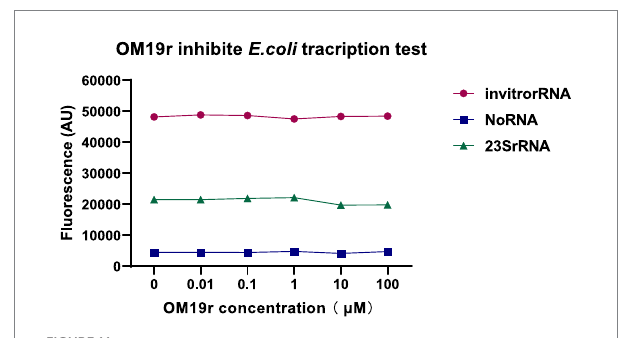
FIGURE 11 The effect of OM19r on the transcription process of E. coli determined by constructing the transcription system in vitro . Graphs show mean of three biological